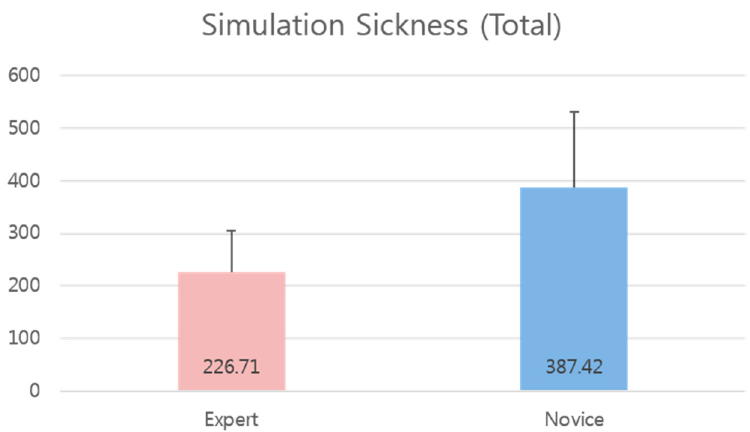
Figure 13. Simulator Sickness Questionnaire scores between the expert and novice user groups.